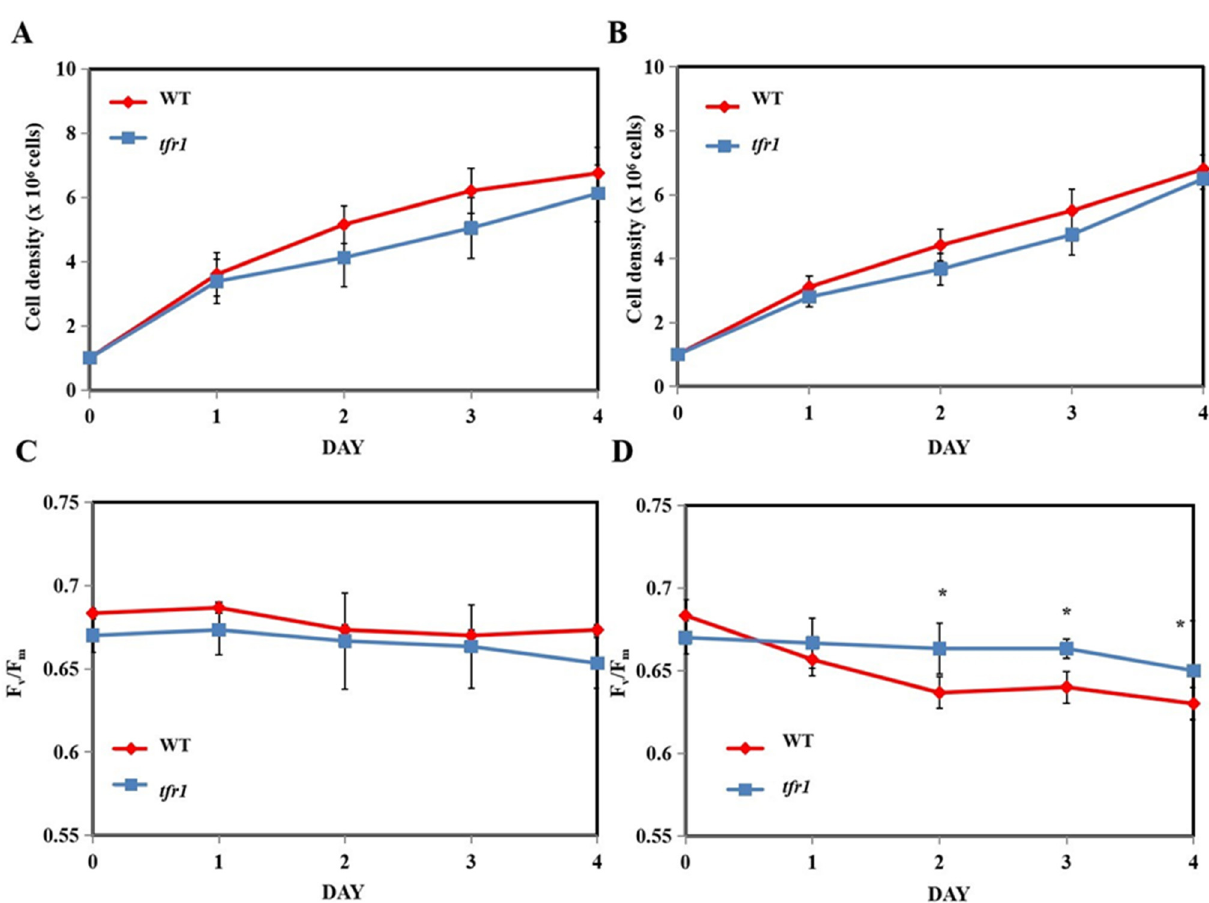
Figure 7. Growth and maximum quantum yield (F v /F m ) parameter of wild type (WT) and tfr1 mutant in nitrogen-replete medium ( A , C ) and nitrogen-replete medium with terbinafine ( B , D ). All data are means ± SD of three biological replicates. Significant differences between the wild type (WT) and the mutants within the same condition are indicated by asterisks (*) ( p <